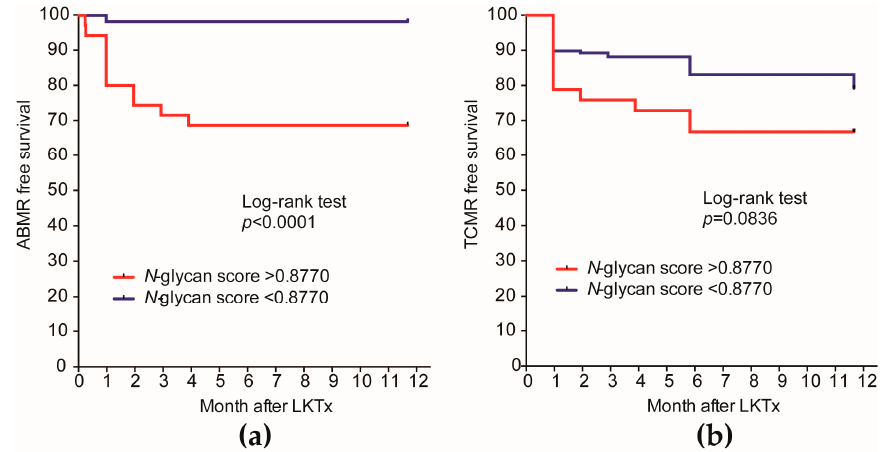
Figure 5. Kaplan–Meier curves for ABMR-free survival and TCMR-free survival of the recipients classified by N -glycan score status. ( a ) The recipients with N -glycan scores >0.8770 had significantly worse ABMR-free survival; ( b ) The recipients with N -glycan scores >0.8770 did not show a significant difference in TCMR-free survival.